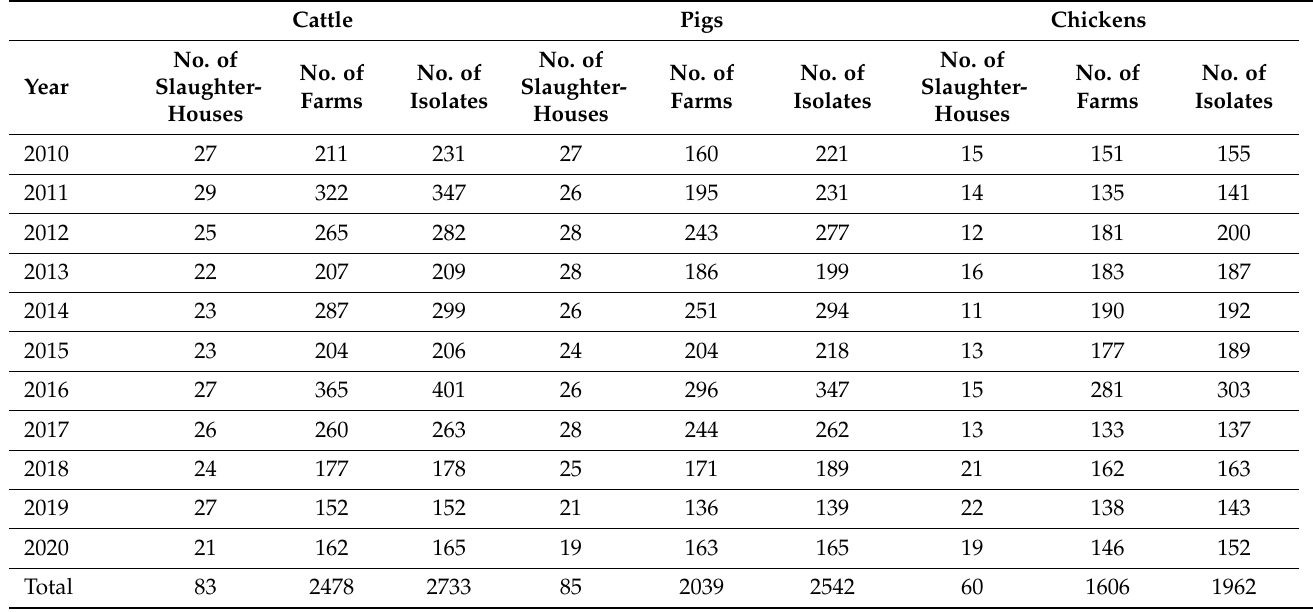
Table 1. E. coli isolates obtained from feces of healthy cattle, pigs, and chickens during 2010–2020 in